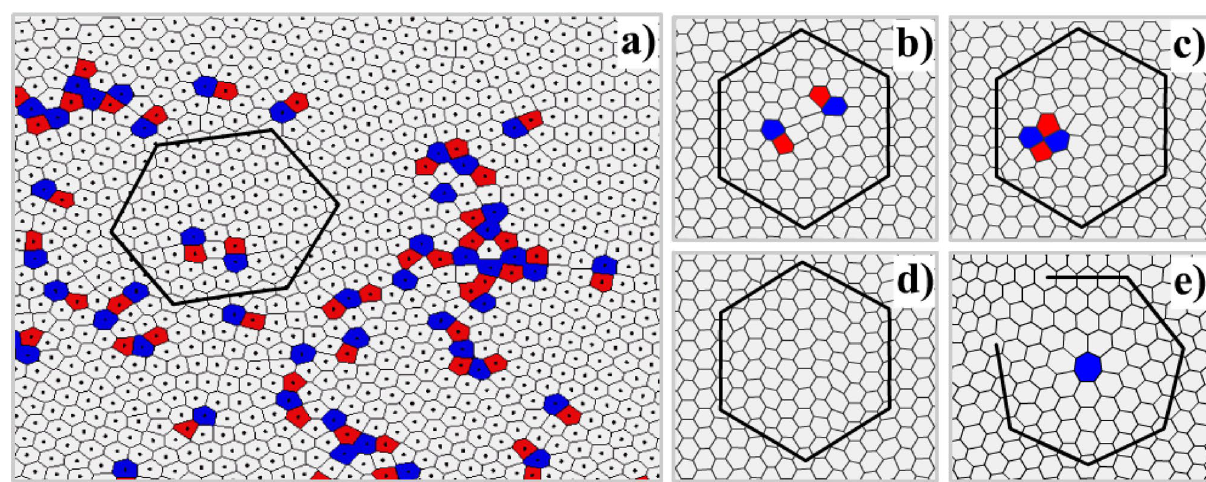
Figure 5. Illustration of ( a ) the Voronoi diagram for the hexatic phase at Γ * ~ 140. Dots indicate particles’ position. The red and blue Voronoi cells are marked for 5- and 7-folded particles, respectively; gray cells represent nondefect particles with 6 nearest neighbors. Subplot illustrates Burgers path with zero vector for different cases: ( b ) free dislocations with opposite Burgers vectors located on one lattice row, ( c ) dislocation pair ( d ) no defects. All three cases are interchangeable in time. ( e ) 7-folded disclination with non-zero Burgers